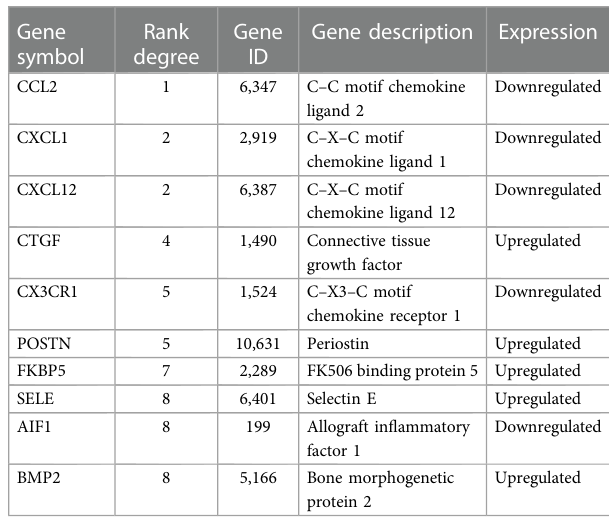
TABLE 2 Description of the top 10 hub